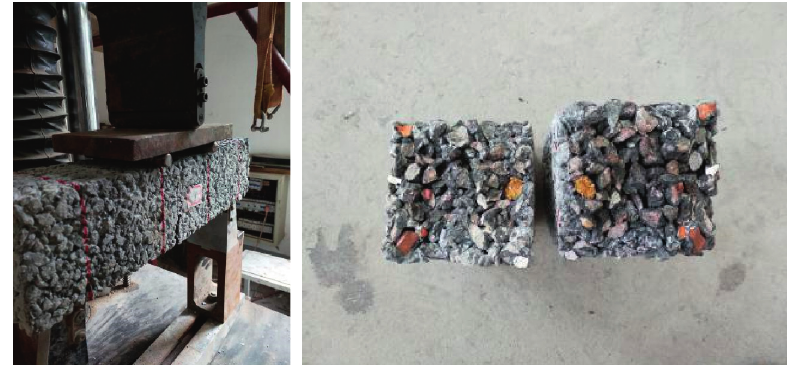
Figure 8: Damage pattern of RAPC under bending flexural tests.